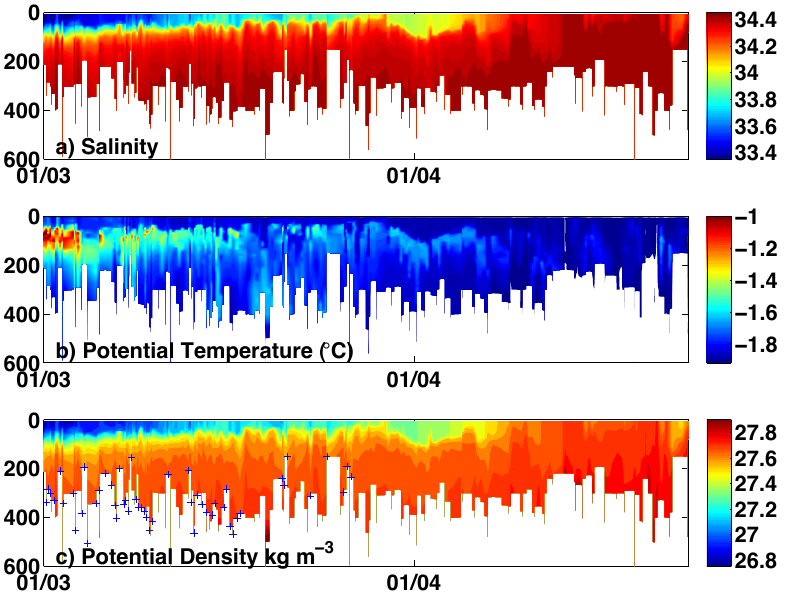
Fig. 8. Vertical sections of (a) salinity, (b) potential temperature (C ◦ ) and (c) potential density (kgm − 3 ) for seal CTD data in Commonwealth Bay. Profiles collected by seal I1 indicated by blue “+” symbol.